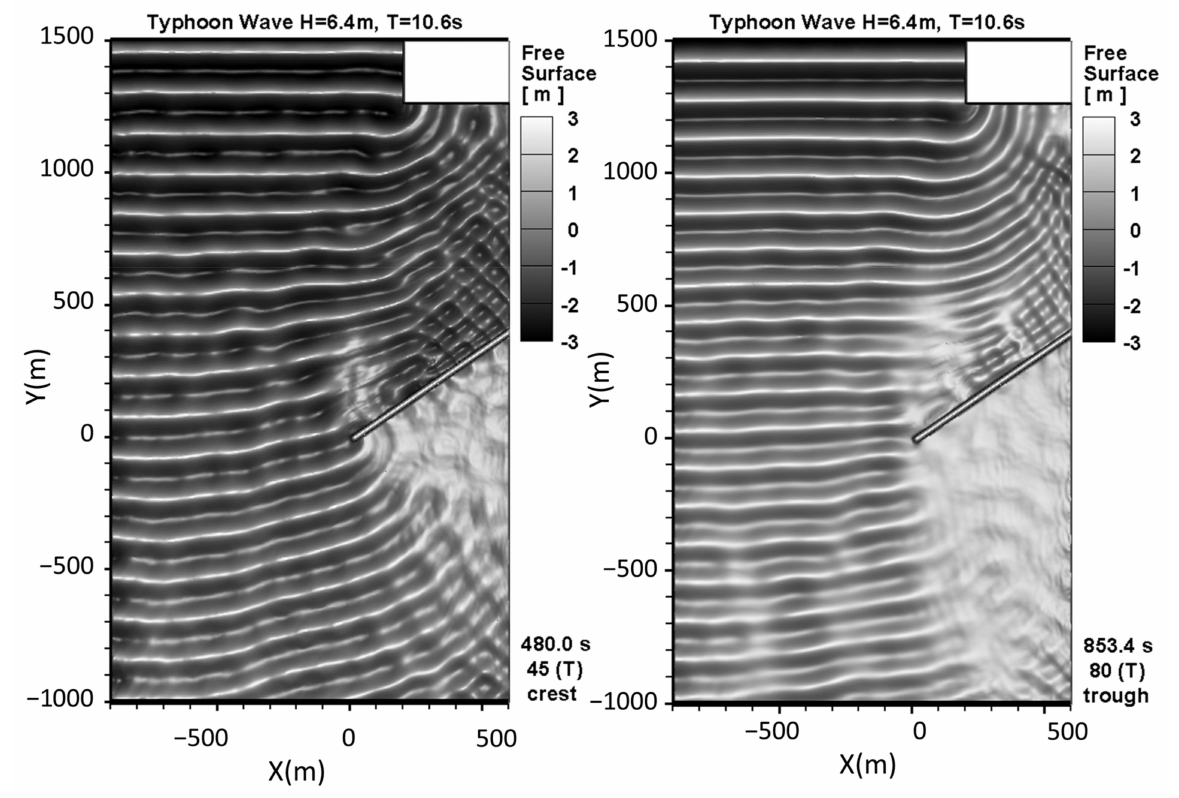
Figure 31. Water surface of simulated wave field.